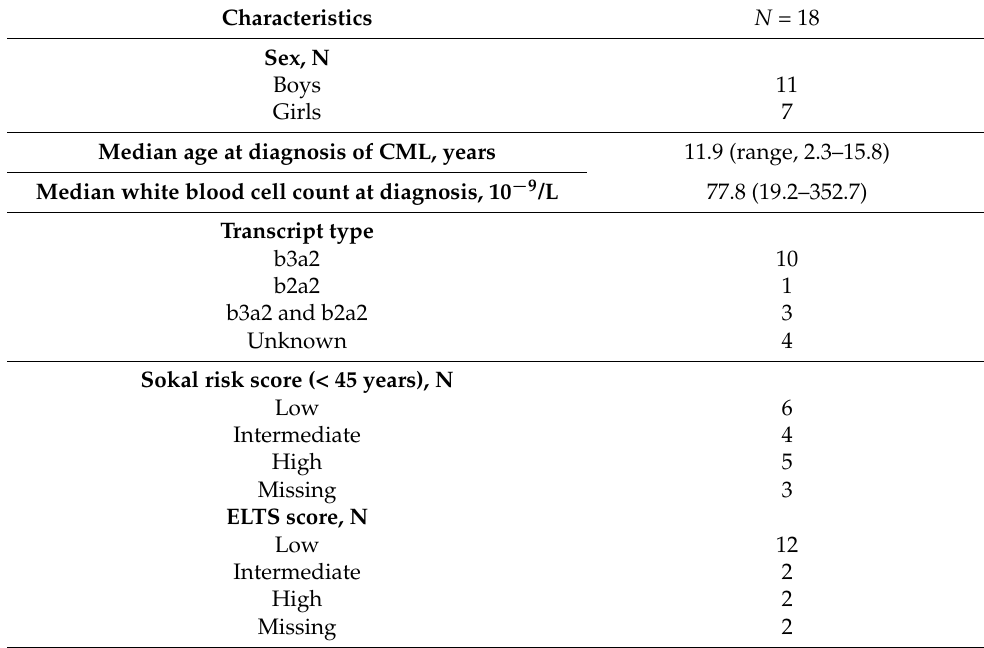
Table 1. Patients’